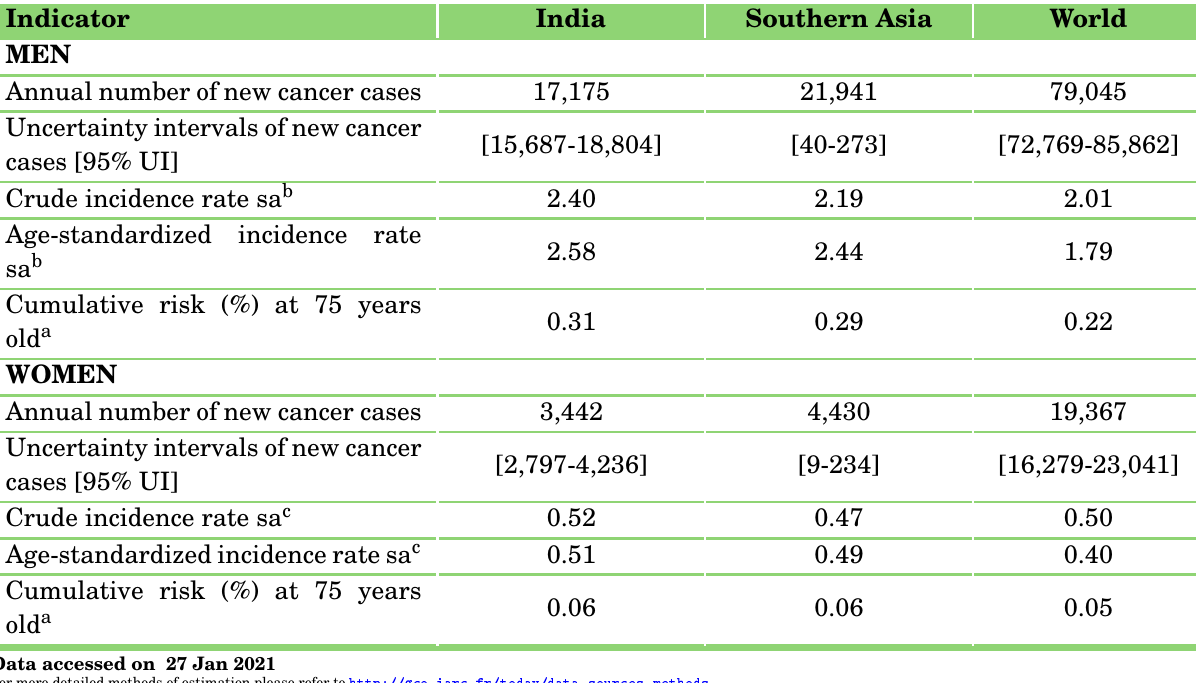
Table 15: Oropharyngeal cancer incidence in India (estimates for 2020) Indicator India Southern Asia